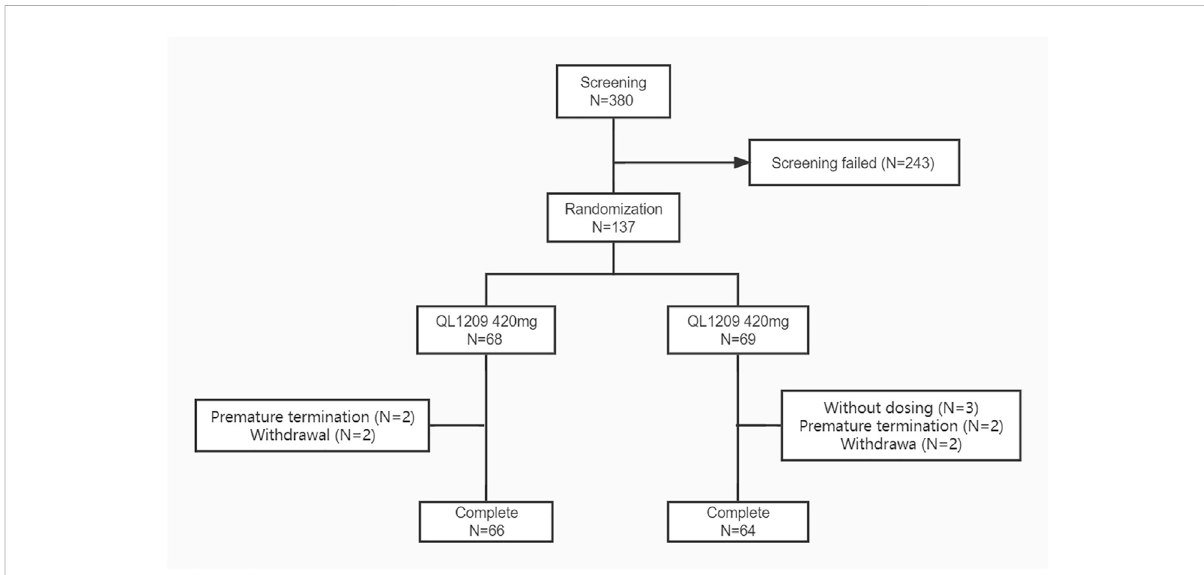
FIGURE 1 Subject fl ow chart. N: The number of subjects. Screening failed mean subjects who did not meet the inclusion criteria or exclusion criteria.